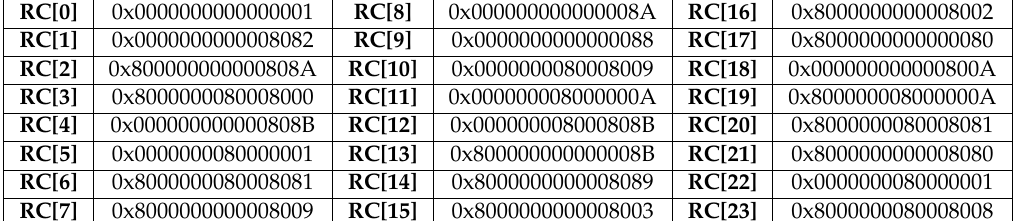
Table 1. The round constants RC [ i ] of keccak algorithm.